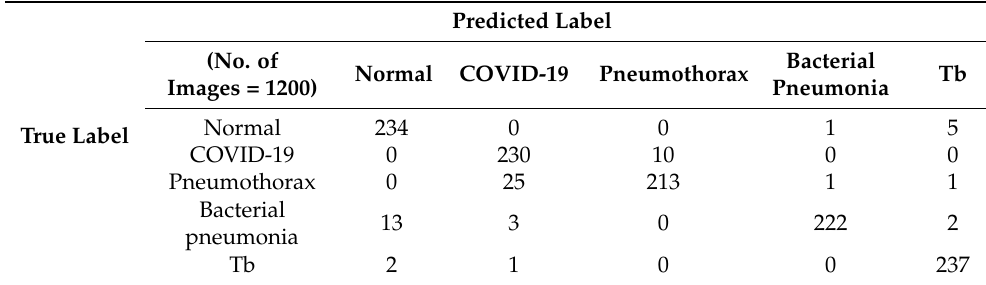
Table 10. Validation confusion matrix of DenseNet169 for five-class